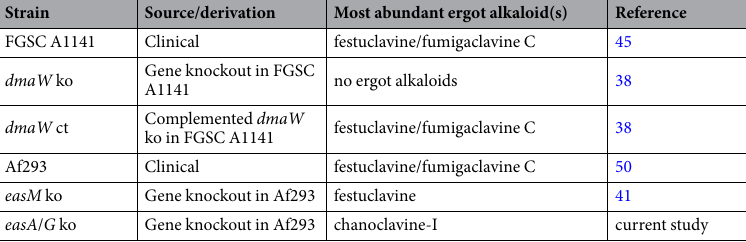
Table 1. Strains of Neosartorya fumigata included in this study.